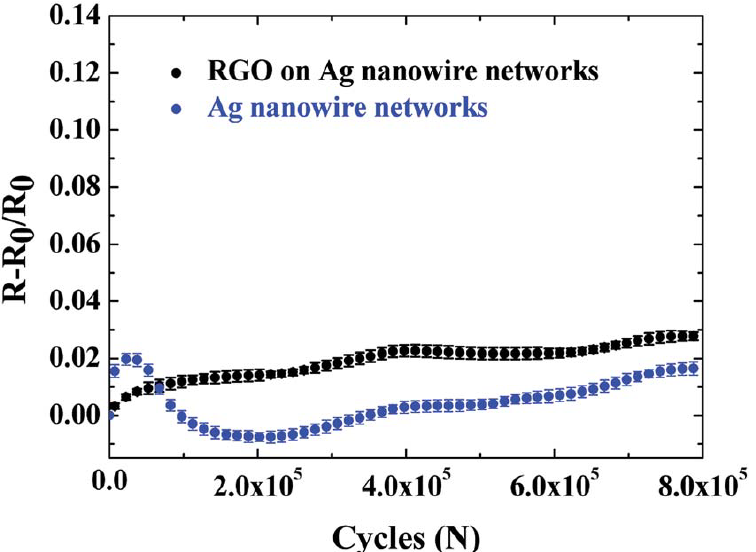
Figure 14. Cyclic bending test results of annealed silver nanowire networks with and without RGO coating. Reproduced with permission from ref. [49] with permission from The Royal Society of Chemistry.